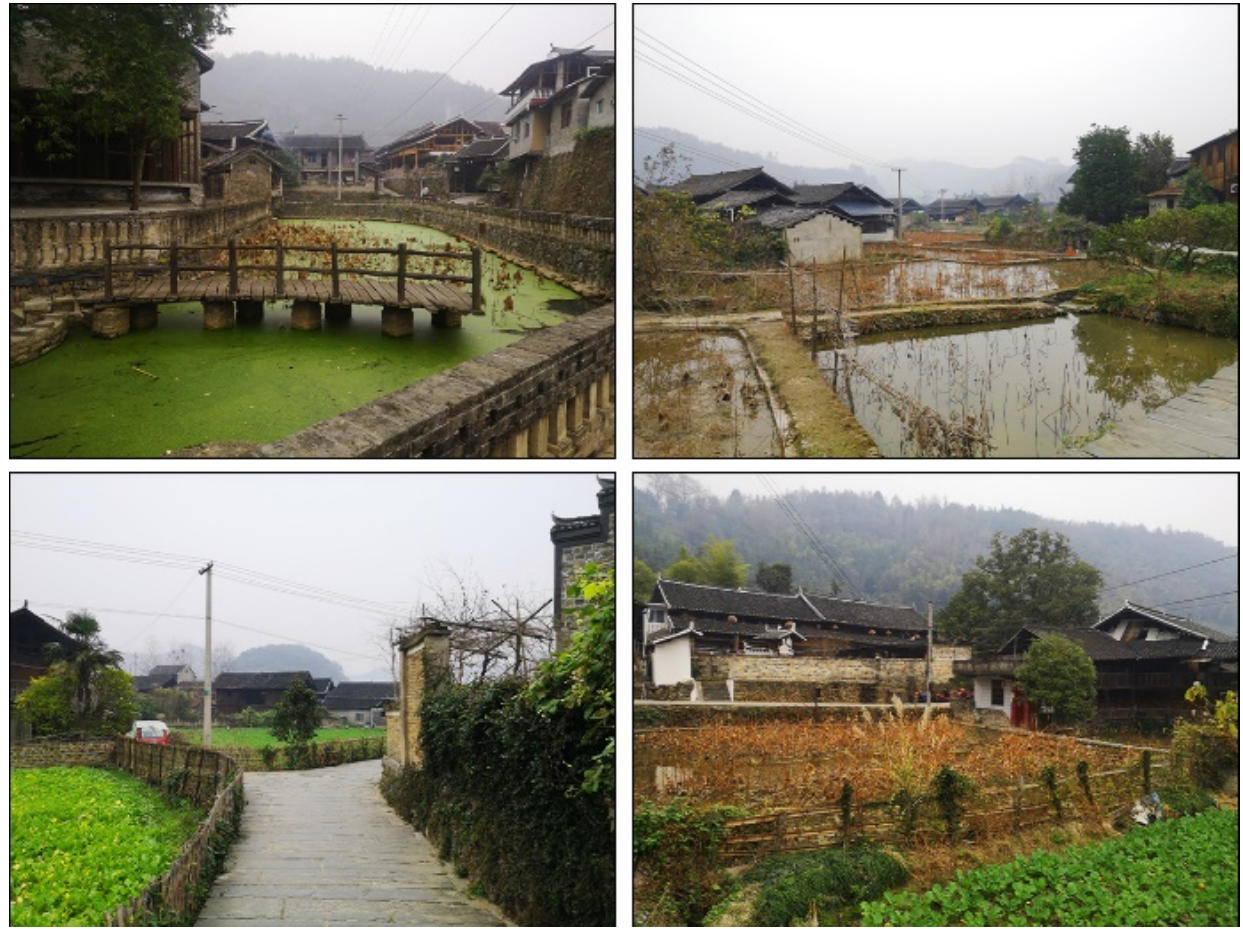
Figure 5. Water ponds and fields of High chair Village.